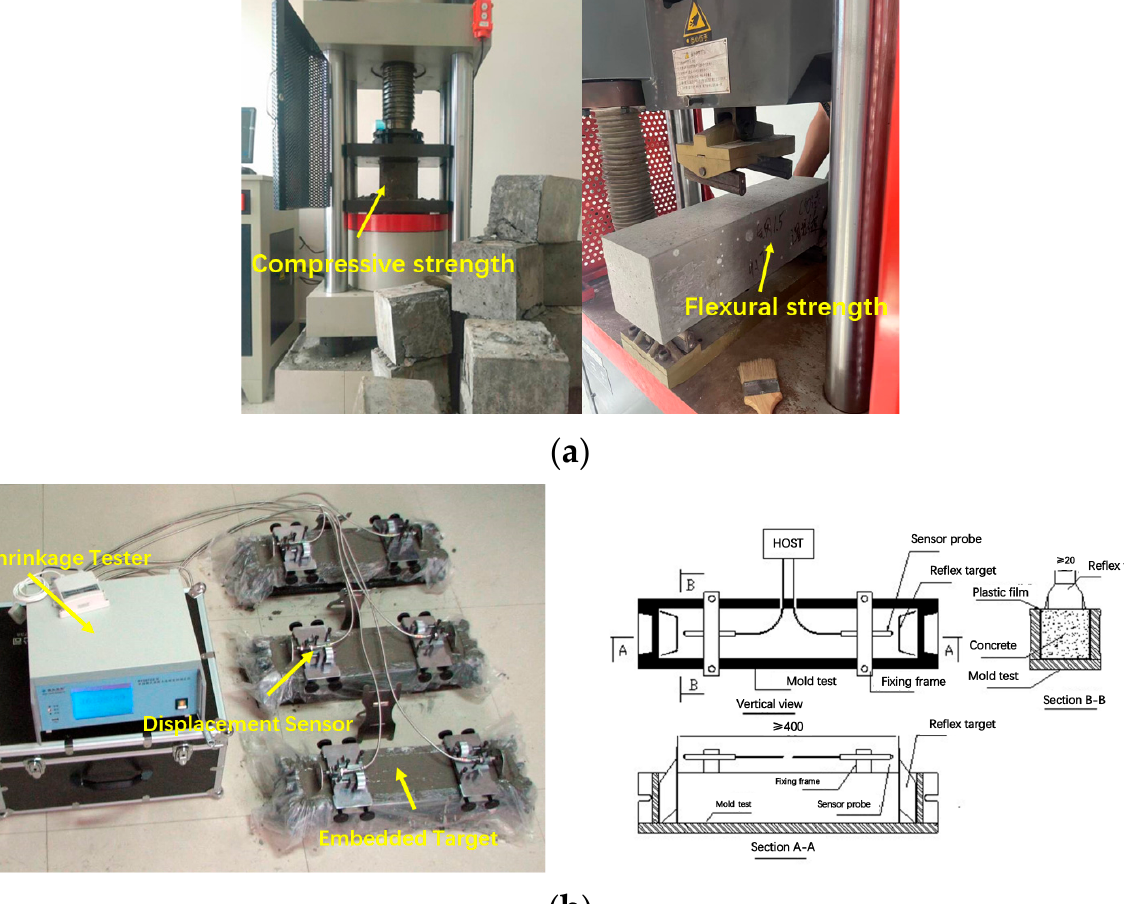
Figure 1. High-strength concrete test. ( a ) Strength test of high-strength concrete. ( b ) Non-contact shrinkage measurement and structural schematic diagram.